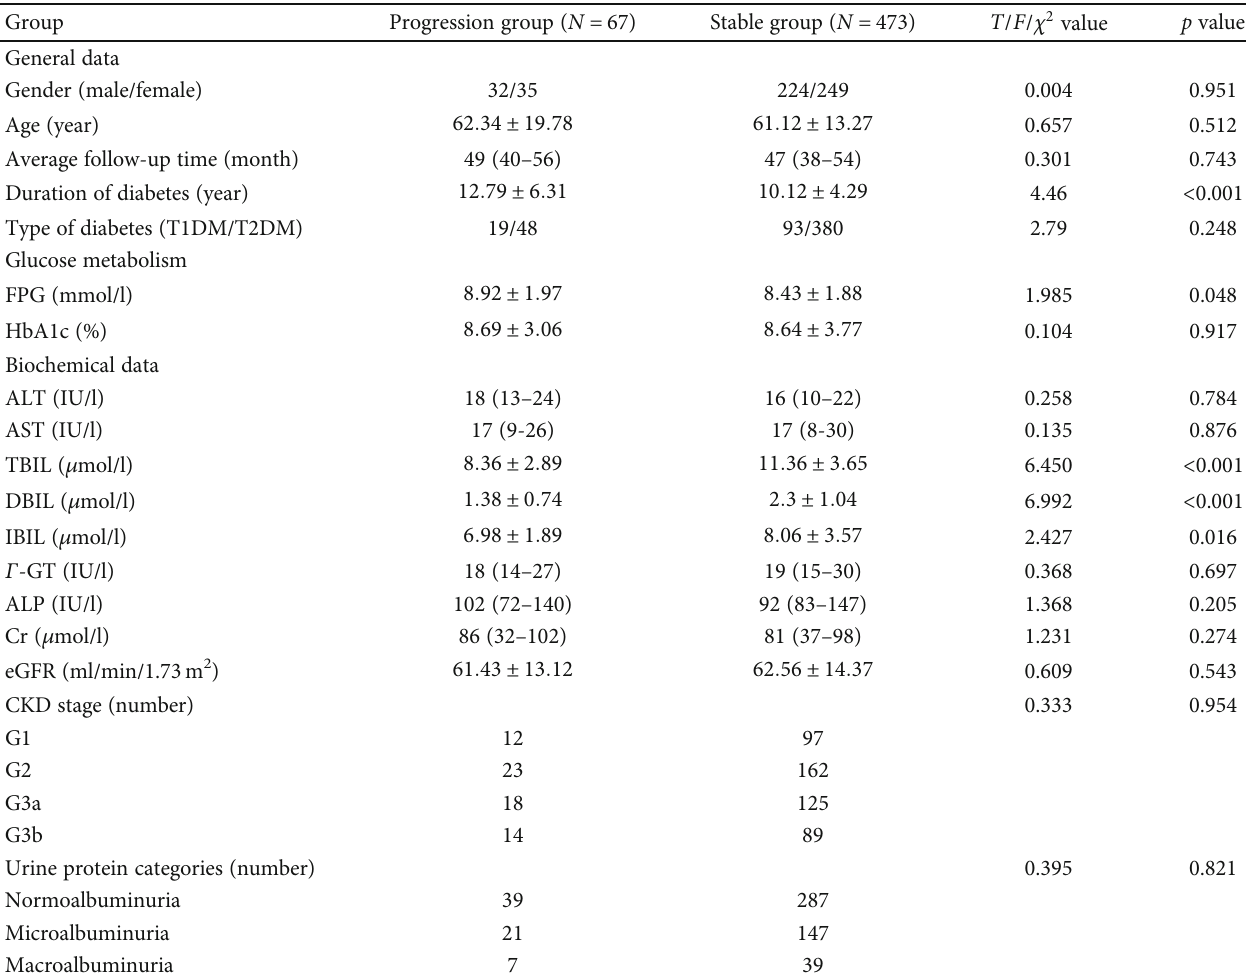
Table 1: Demographic and metabolism characterization of study